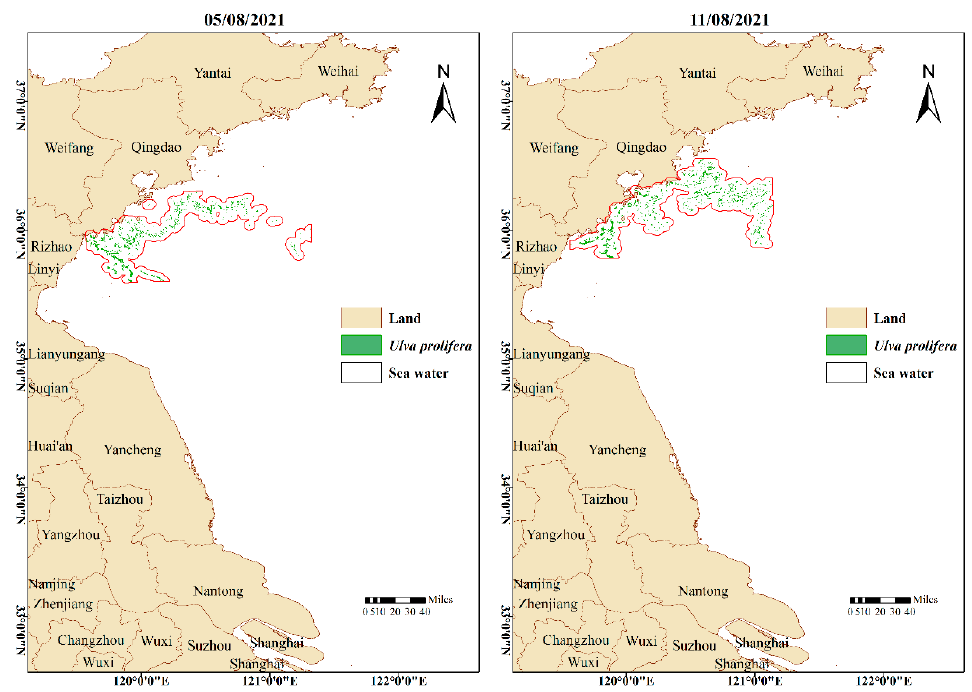
Figure 13. The thematic map of the extraction results of Ulva prolifera and the affected area. Connect the geometric centers of Ulva prolifera in sequence to obtain the drifting path of Ulva prolifera, as shown in Figure 14. Ulva prolifera was first detected by satellites on 24 May, located in the northern waters of Yancheng. From 24 May to 6 June, it drifted to the open sea along the northeast direction. After 6 June, it drifted to the northwest, passing through the waters of Lianyungang, Linyi, Rizhao and Qingdao, and finally staying in the waters of Qingdao. Ulva prolifera tends to gather, grow and expand to the north as a whole.